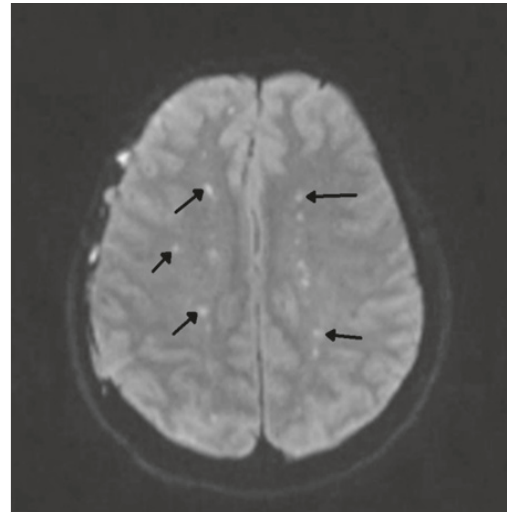
Figure 1: Right Femur X-Ray showing acute femur fracture (black arrow). Figure 2: Brain MRI revealed multiple bilateral acute cerebral infarcts (black arrows) with restricted diffusion areas in a “starfield” pattern favoring fat